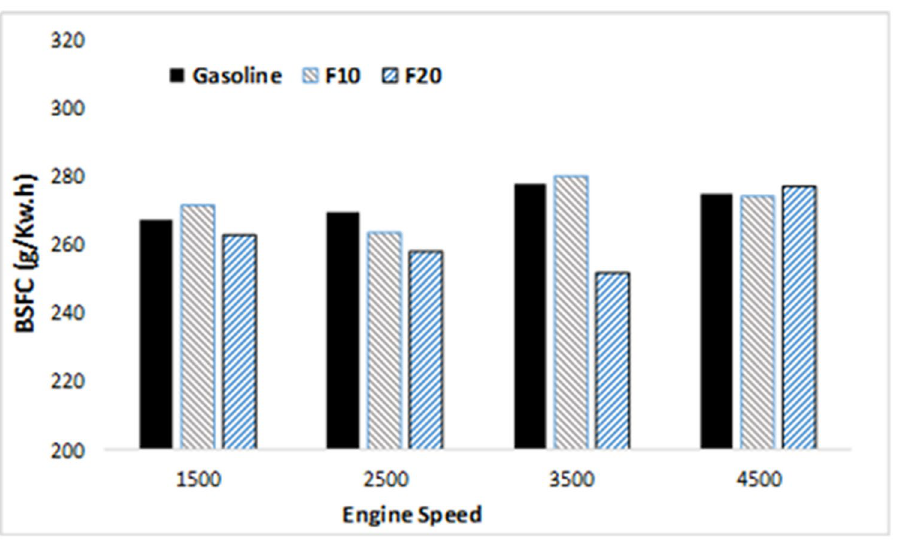
Figure 4. BSFC variation with increasing engine